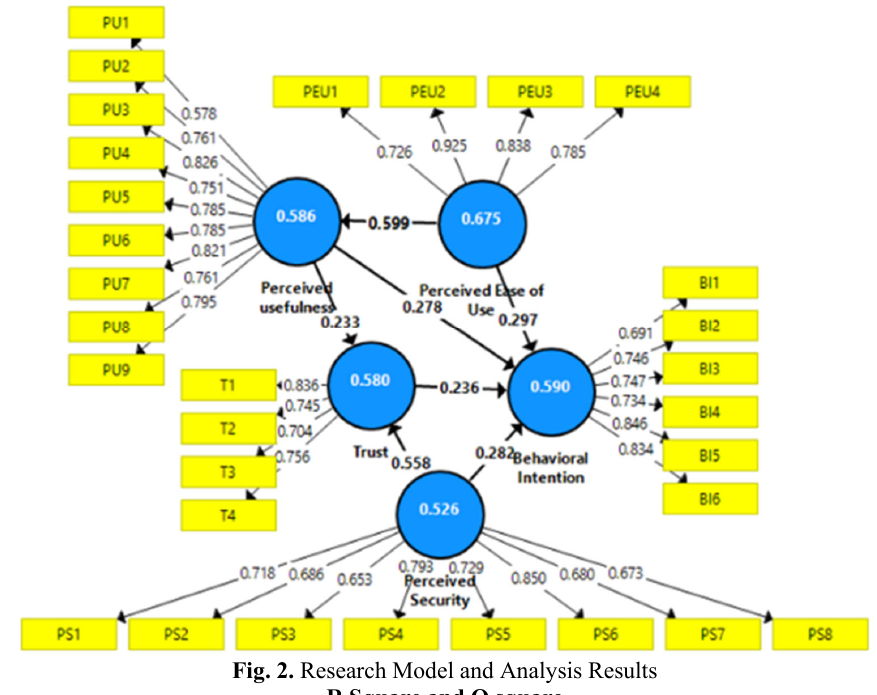
Fig. 2. Research Model and Analysis